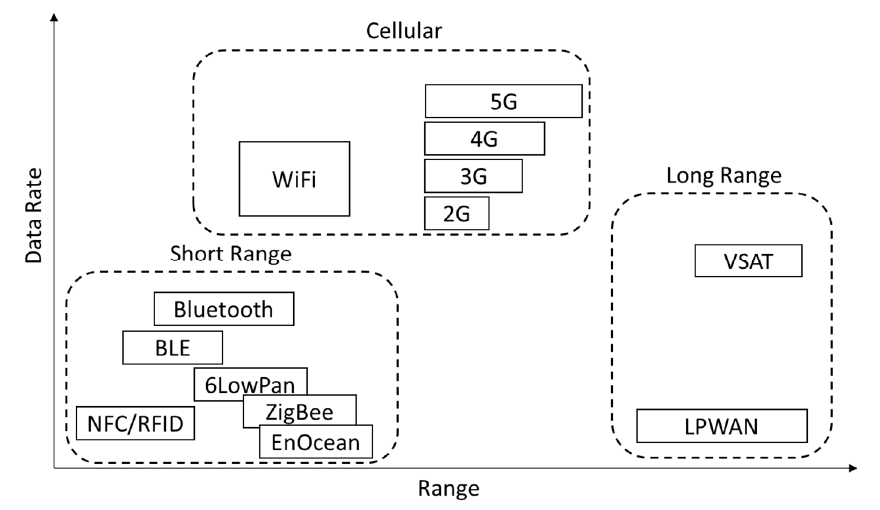
Figure 4. Data rate vs. (aboveground) range of radio communication technologies. Reprinted/adapted with open access permission from Ref. [27].